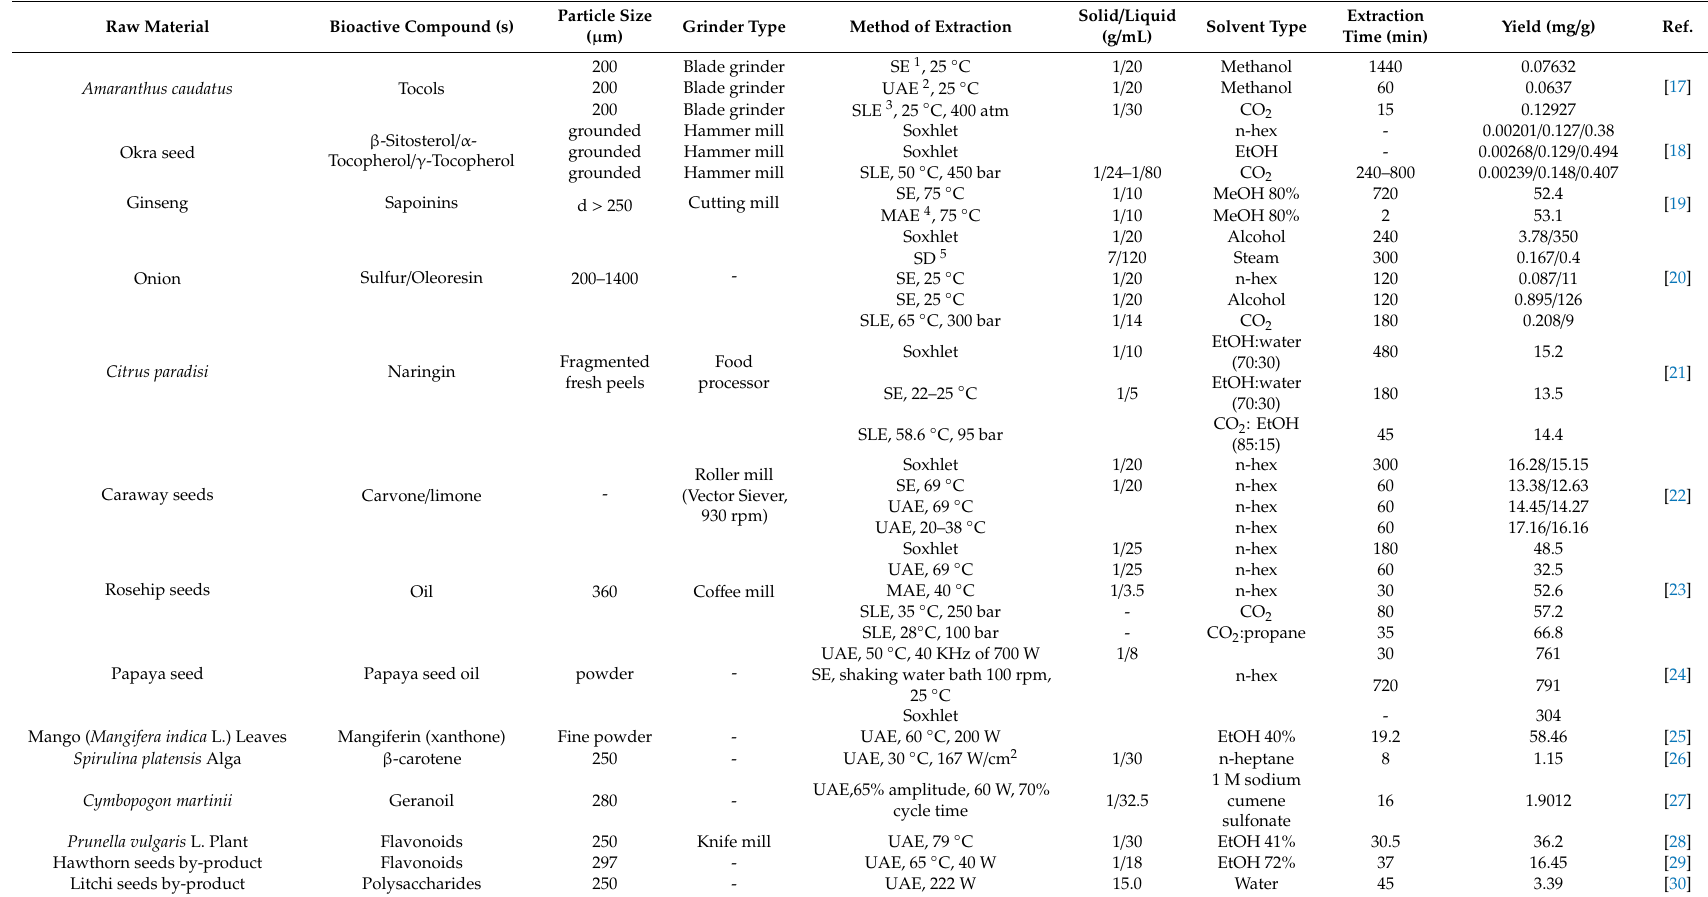
Table 1. Studies on the extraction of valuable compounds from various source